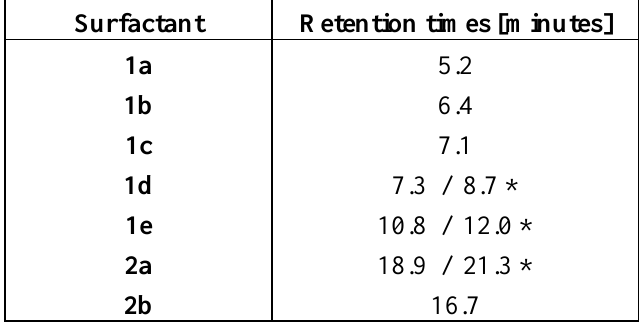
Table 1. Retention times for surfactants 1a - e and 2a - b , using a 30:70 water-acetonitrile mixture as eluent and MPI, 3 , as the ion-pair auxiliary. Detection at λ = 258